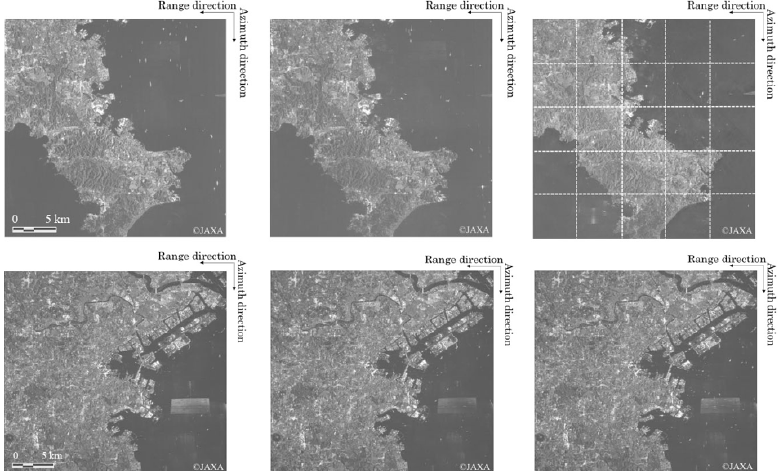
Figure 1. Spotlight SAR images of the waters around the Miura peninsula, Japan. The images of ships in Tokyo Bay on the right in the upper images are used for training and validation of the deep learning algorithm. For computational purposes, each image is divided into 25 small sections, as shown in the upper-right image. The lower 3 images are the samples used for the test.